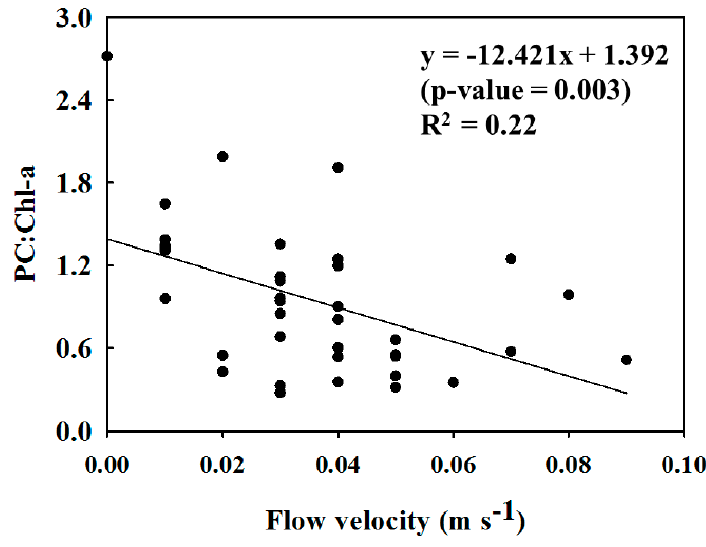
Figure 16. Relationship between flow velocity and the ratio of PC and Chl-a on 12 and 24 August